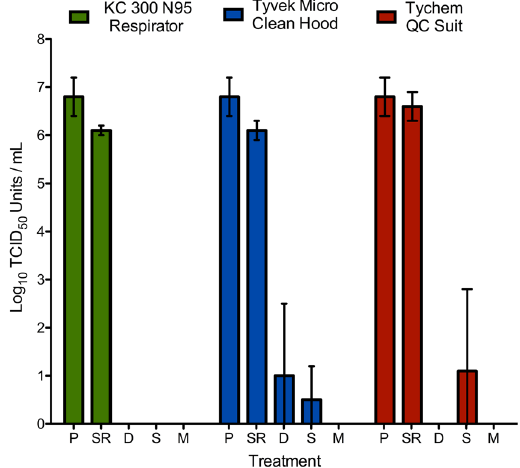
Figure 2. Ebola virus penetration through three types of protective material, which allowed the virus to persist for ≥ 24 hrs at 27 °C and 80% relative humidity. Virus was inoculated onto the surface of a dry or saturated coupon and left to incubate at 21.5 °C and 30–35% RH for 30 minutes. The coupons were then swabbed on the exposed and unexposed side to recover the virus used in the challenge and detect viral penetration through the material. Where: P- positive (inoculation/challenge) control, SR- swab recovery, D- dry sample, S-saturated sample, M- mock. The PPE Penetration experiments were performed in four biological replicates, each consisting of one technical repetition. Reported values are the average across all replicates (n = 4) error was calculated as standard error of the